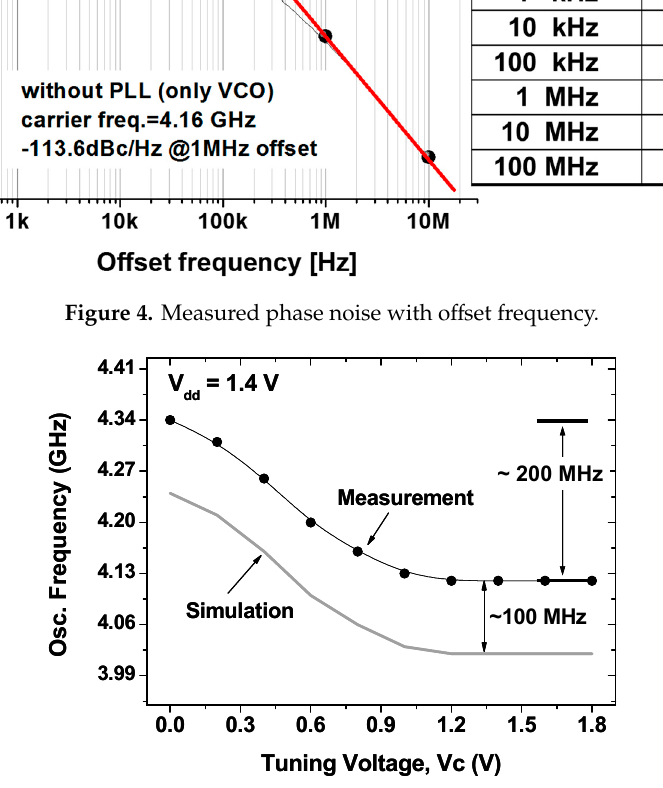
Figure 5. Comparisons between measured and simulated results.